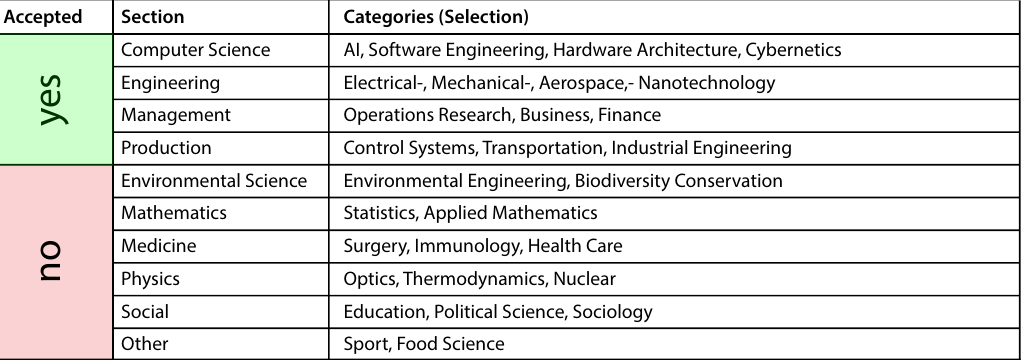
Figure 5. Relevant Web of Science Categories.